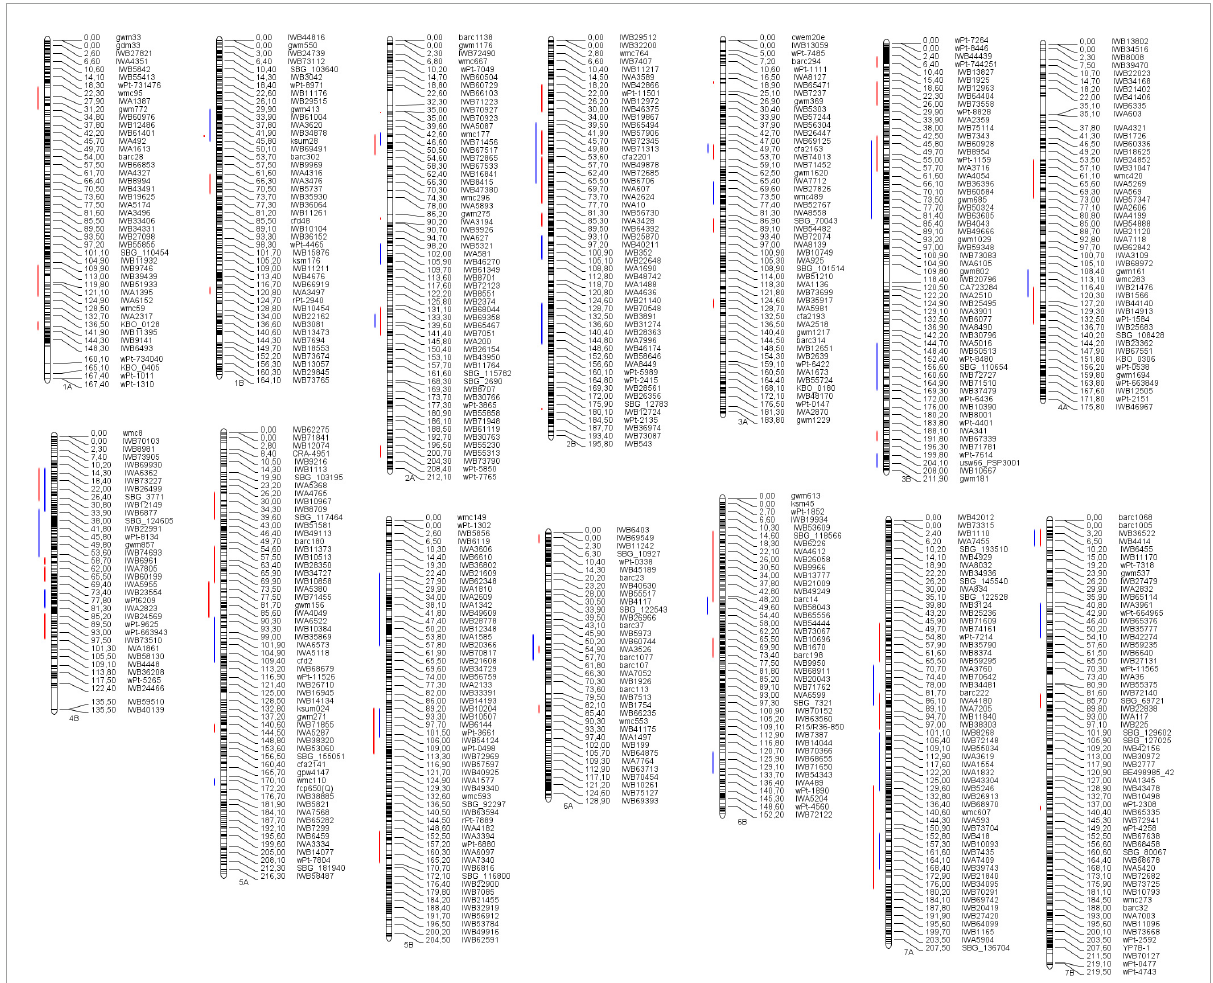
FIGURE4 Distribution of the MQTL throughout all 14 chromosomes (genomes A and B) of durum wheat. A total of 76 MQTL were detected under irrigated conditions (blue bars), and under rainfed conditions (red bars). Black bars within chromosomes represent marker density, and to the right is the distance in cM and marker